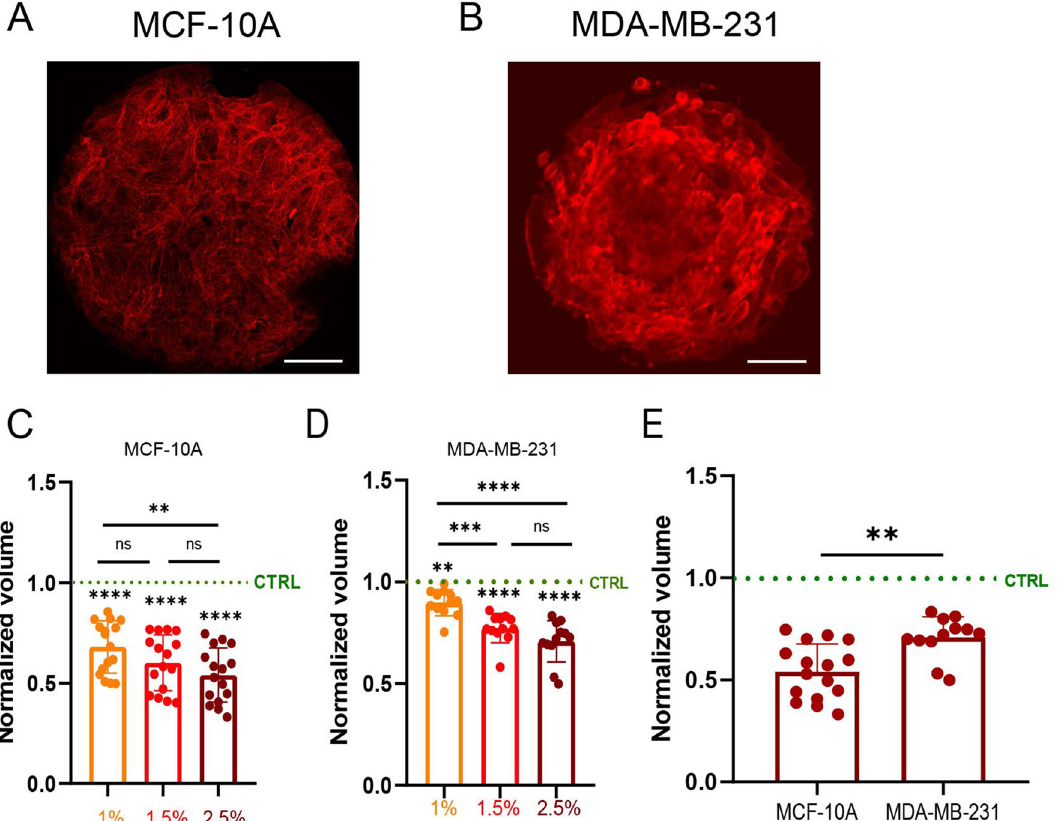
Figure 3. Moderate osmotic stress leads to cell volume loss, but tumorigenic breast mesenchymal epithelial cells are less sensitive to osmotic stress. Immunofluorescence images of ( A ) MCF-10A and ( B ) MDA-MB-231 minimal tissues grown on circular FN micropatterns of 200 µm in diameter. Actin is stained in red. Scale bar corresponds to 40 µm. Normalized volumes of ( D ) MCF-10A and ( E ) MDA-MB-231 micropatterned tissues treated with different PEG concentrations: 1% (yellow), 1.5% (red) and 2.5% (dark red). For each cell type, the volumes of PEG-treated tissues are normalized with the volume of micropatterned tissues. n = 16 (MCF-10A), n = 12 (MDA-MB-231). *0.01 < p < 0.05, **0.001 < p < 0.01, ***0.0001 < p < 0.001, **** p < 0.0001 and ns non-